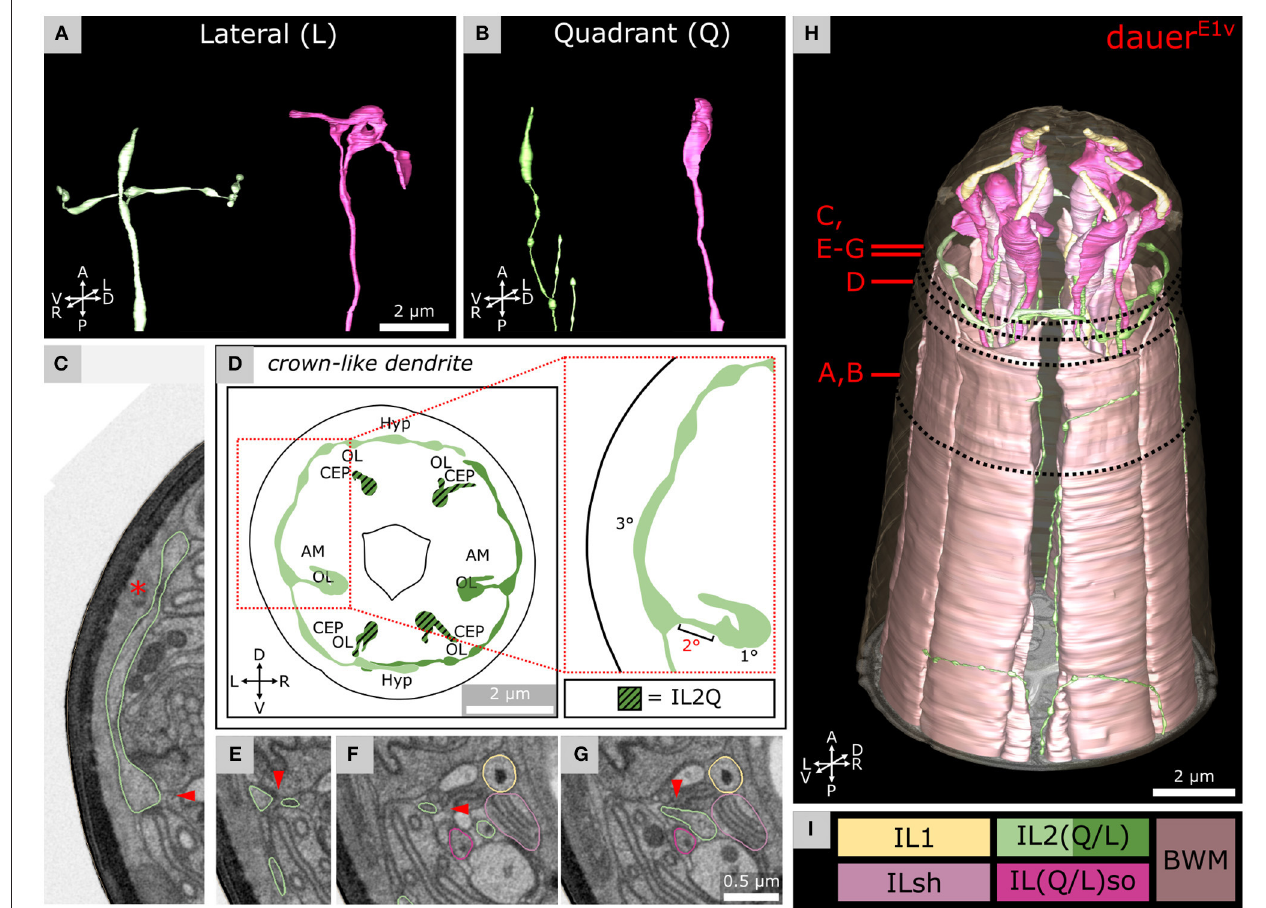
FIGURE 3 | Morphology of dauer-specific crown-like dendrites of lateral IL2 endings. (A) Example of the morphology of IL2LL (panel left) and ILLso (panel right) cell endings. As an example, only left cells are shown. IL2LL has a crown-like dendrite projecting to the dorsal and ventral sides. ILLsoL shows two branches. (B) Example of the morphology of IL2Q (panel left) and ILQso (panel right) cell endings. Dorsal-left cells are shown as examples. IL2QDL shows no crown-like dendrite , but several other dendritic branches are located more posteriorly. ILQsoDL shows no branches. (D) Schematic 2D projection of IL2 sensory endings including crown-like dendrites of a volume containing 5 µ m from the anterior of the model. IL2Q is graphically hatched. (C,E–G) Four transverse FIB-SEM sections following the small 2 ◦ dendrite (arrowhead) from the 1 ◦ dendrite to the crown-like dendrite (which is a 3 ◦ dendrite). Asterisk in C indicates the Hyp syncytium, which together with the cuticle forms the only barrier to the environment for the crown-like dendrite . Panels are oriented on the same level in Y-dimension. C is on the same level as Figure 2C . (H) 3D reconstruction of all six IL sensilla in context with BWM cell endings. (I) Names and color code of cells